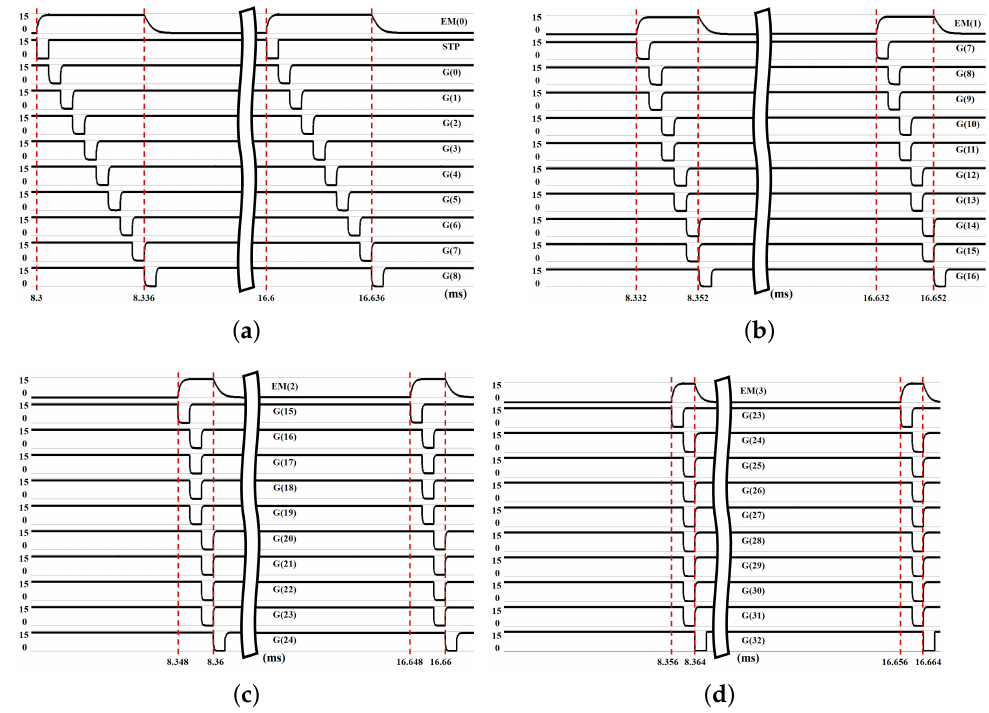
Figure 15. Simulated EM waveforms for four resolution regions: ( a ) original resolution ( f RES ); ( b ) 1/2 resolution ( f RES /2 ); ( c ) 1/4 resolution ( f RES /4 ); and ( d ) 1/8 resolution ( f RES /8 ).